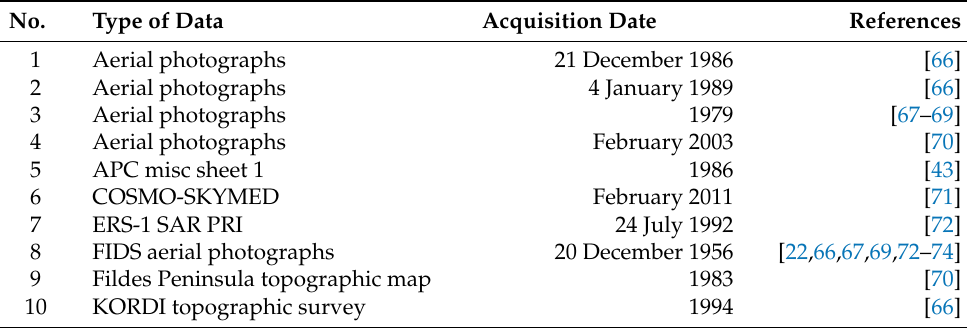
Table 1. Materials used in all previous ice-front-fluctuation